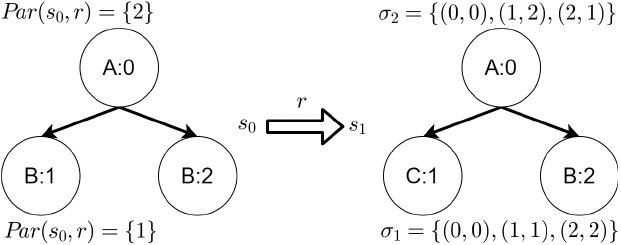
Figure 3. A TTS for the example of how to interpret sets I and T